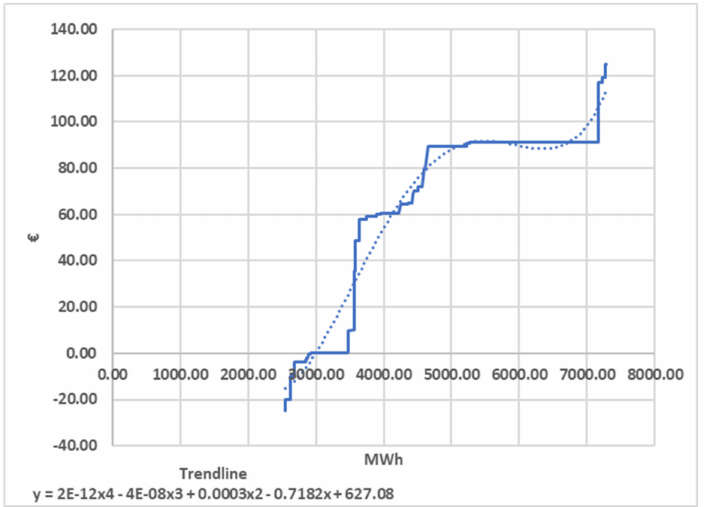
Figure 1. Bid Curves for the Greek Electricity market [5 May 2021 20:00–21:00].